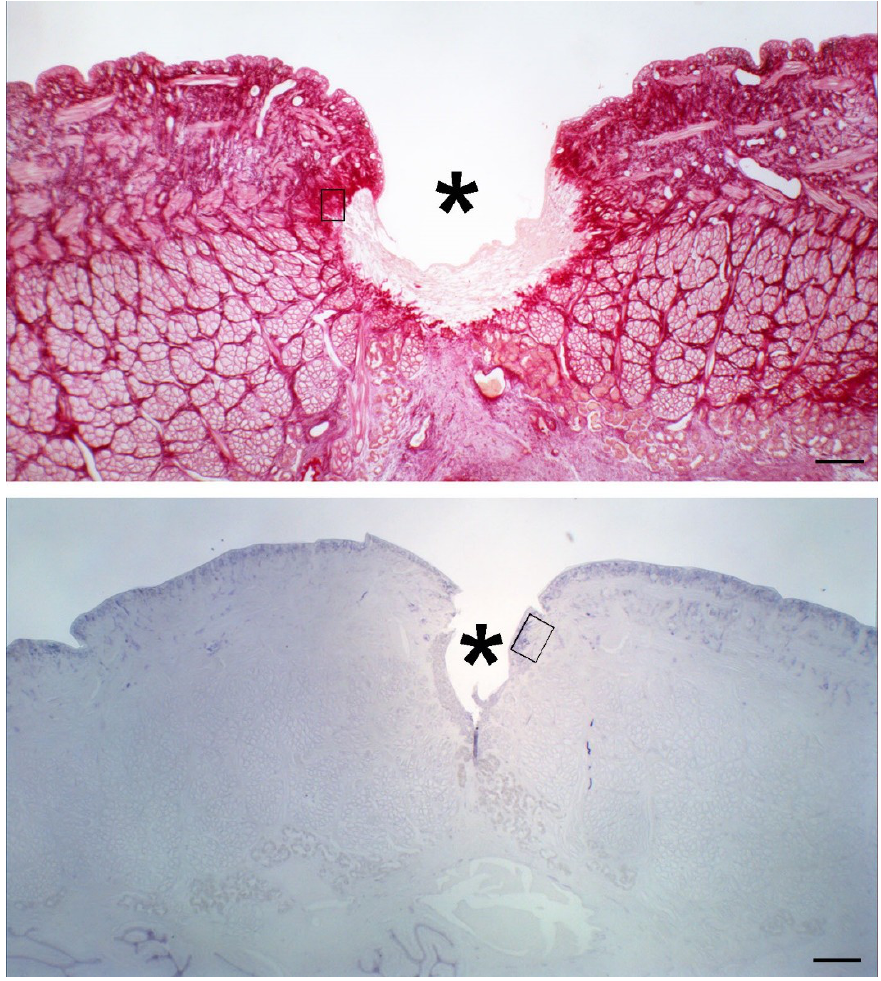
Figure 12. Representative transverse sections of leeches stained with picrosirius red (top) and paraldehyde fuchsin (bottom); the boxes show the tissue areas close to the surgical wound (asterisk) corresponding to the regions of interest (RoI) selected for collagen and elastic fibre densitometry, respectively. Bar = 200 μm.